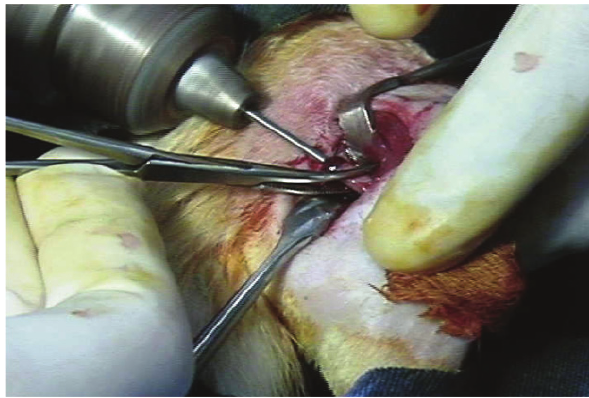
Figure 3 - Intramedullary nail fixation of the